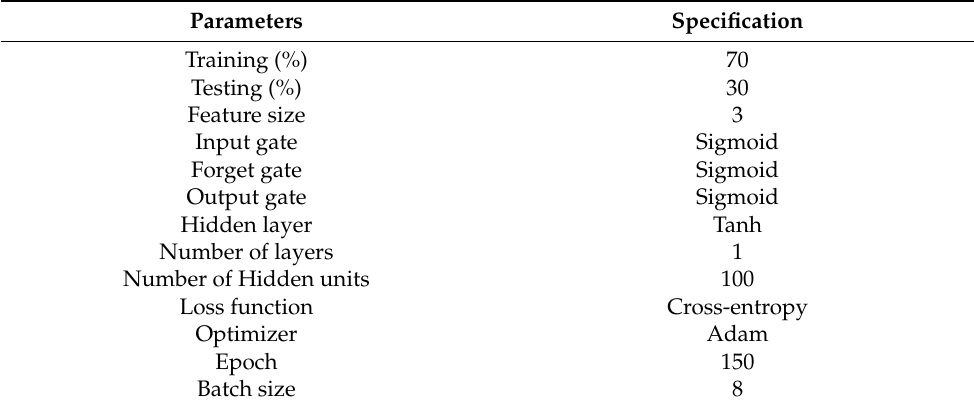
Table 4. LSTM network structure